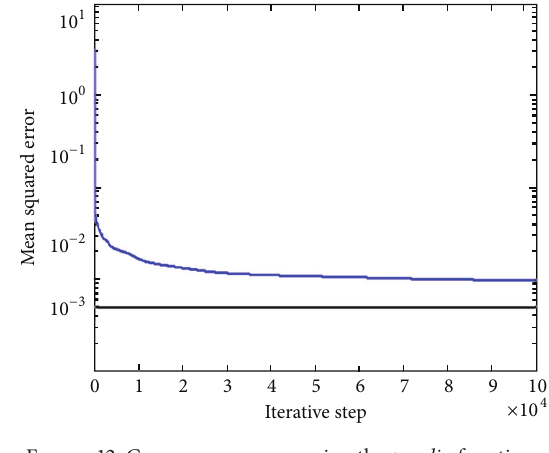
Figure 12: Convergence curve using the purelin function.